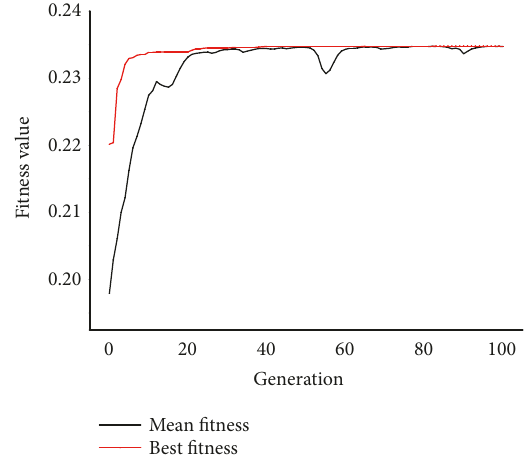
Figure 14: Evolution of the